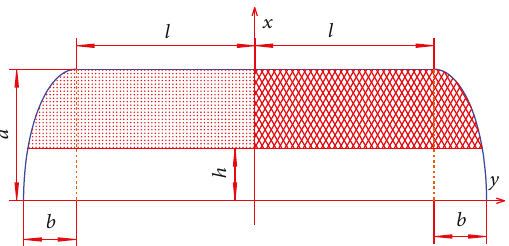
Figure 12: A sample grain to verify the nonuniform burnback